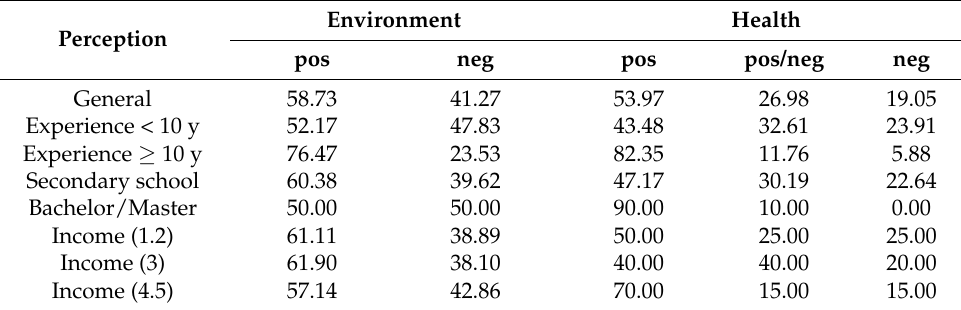
Table 1. Perception of the harmful effects of noise on the environment and health.